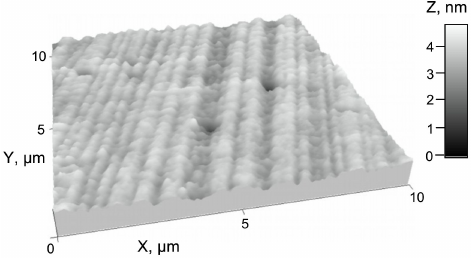
Figure 10. Characteristic atomic force microscopy (AFM) topographical image with normalized Z axis in nm of PETMP-TTT polymer